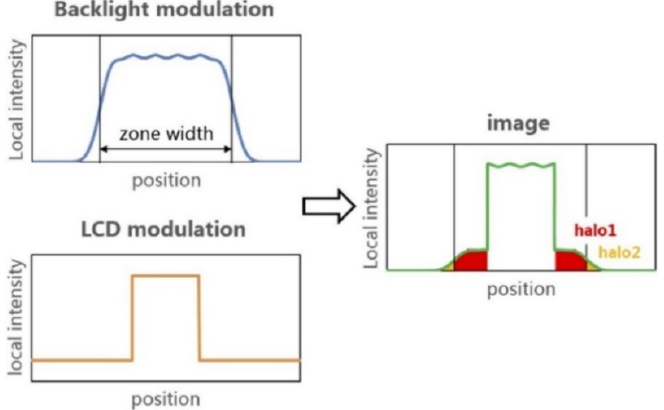
Figure 2. The origin of the halo effect: halo1 is because the zone size is much larger than that of a pixel and halo2 is because of the light leakage from the bright zone to the adjacent dark zone [9].